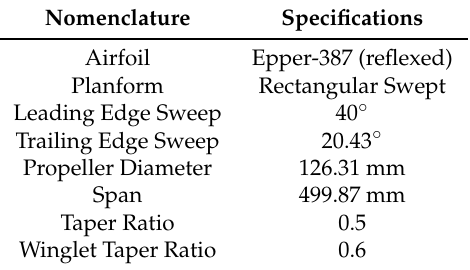
Table 3. Geometric features of flying wing micro aerial